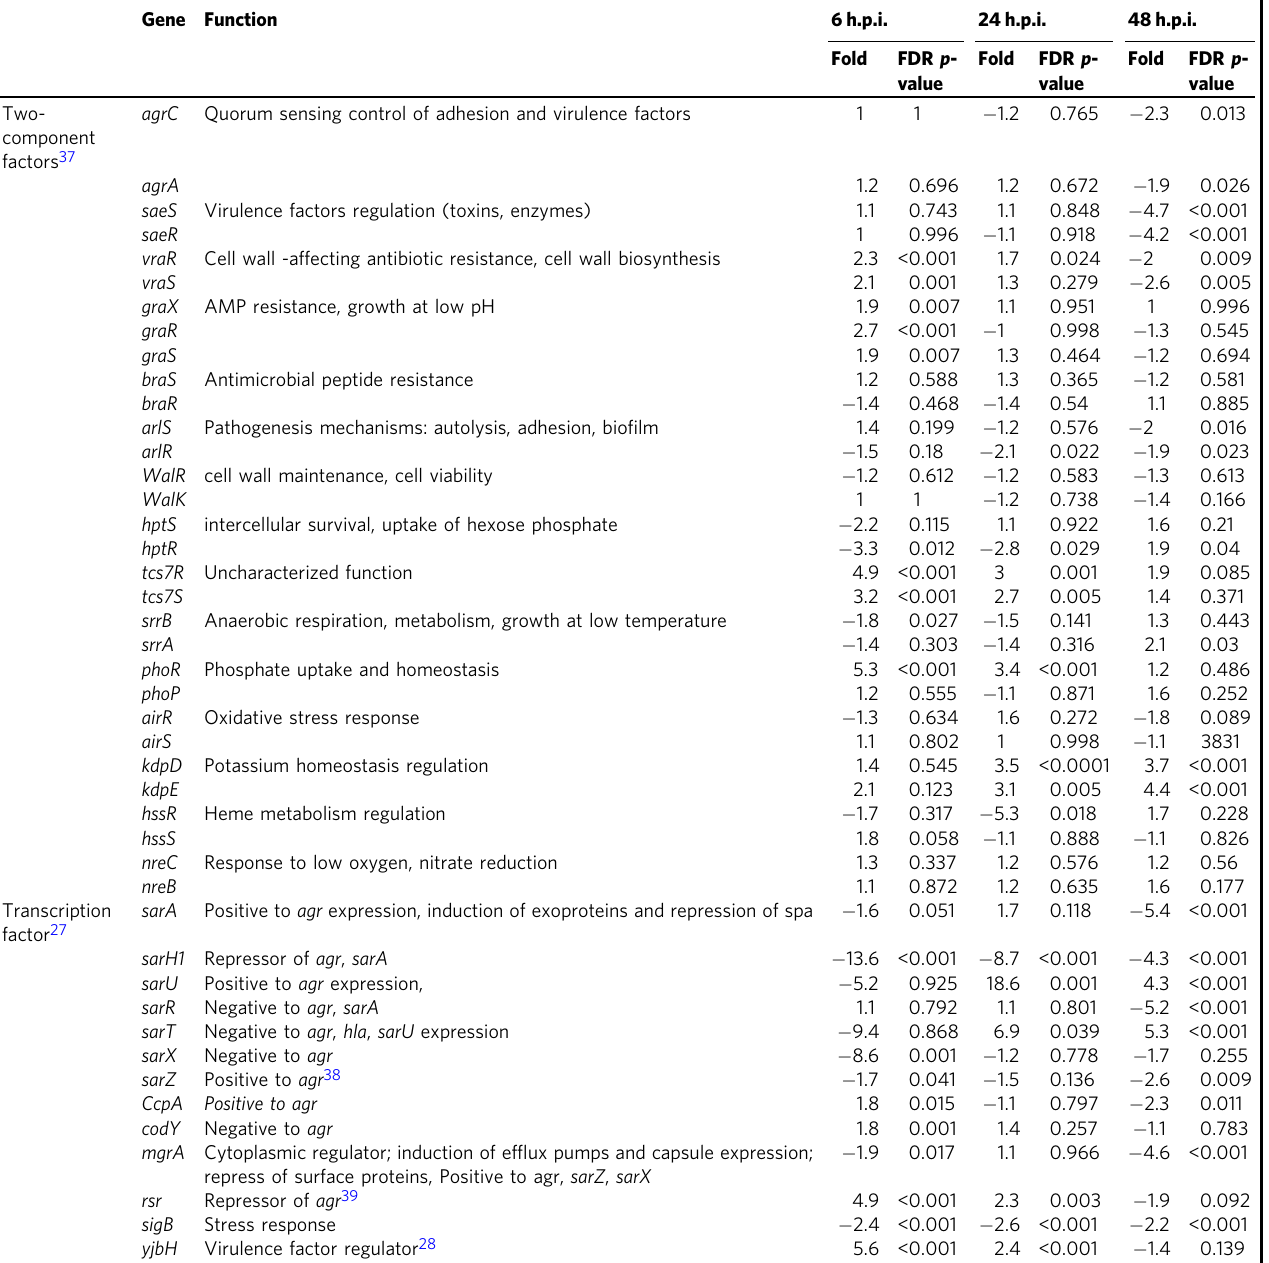
Table 3 Gene expression change in the S. aureus 2-component system and virulence-related transcription factors in the host liver compared with culture